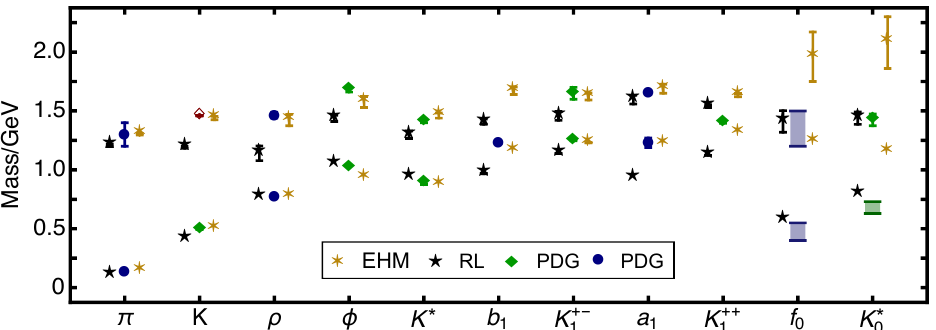
Figure 6. Empirical spectrum [40] (PDG summary tables): blue circles (bars)— u , d states; green diamonds (bar)—systems with s and/or ¯ s quarks. Little is known about K ( 1460 ) , which is therefore drawn as an open red diamond. Gold six-pointed stars—spectrum of low-lying u , d , and s mesons predicted by the EHM-improved Bethe–Salpeter kernel developed in Reference[222]; black five- pointed stars—same spectrum computed using RL